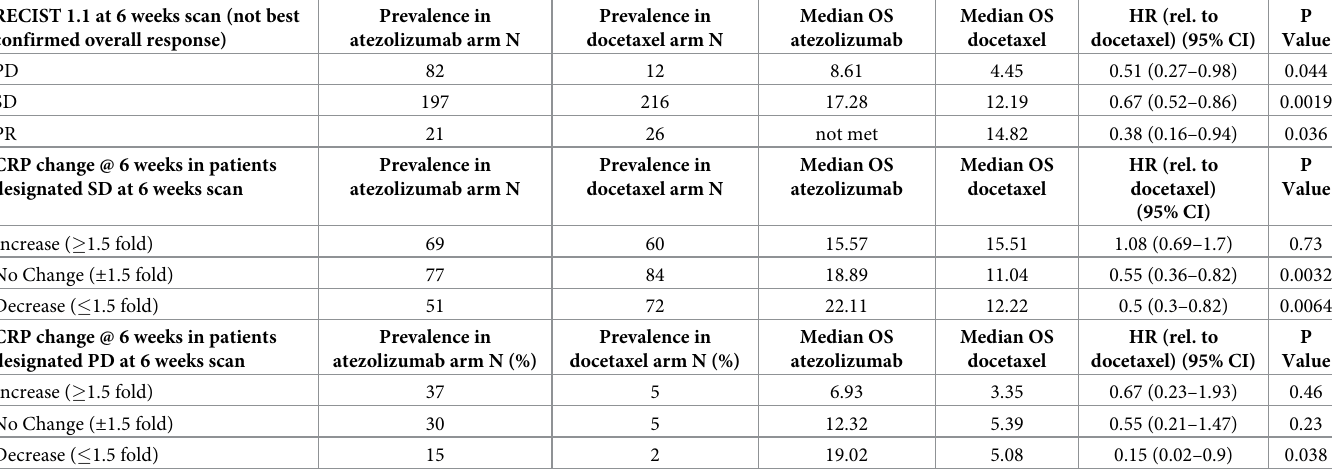
Table 4. OS benefit based on ORR using RECIST 1.1 scans and CRP changes at 6 weeks in OAK. RECIST 1.1 at 6 weeks scan (not best confirmed overall